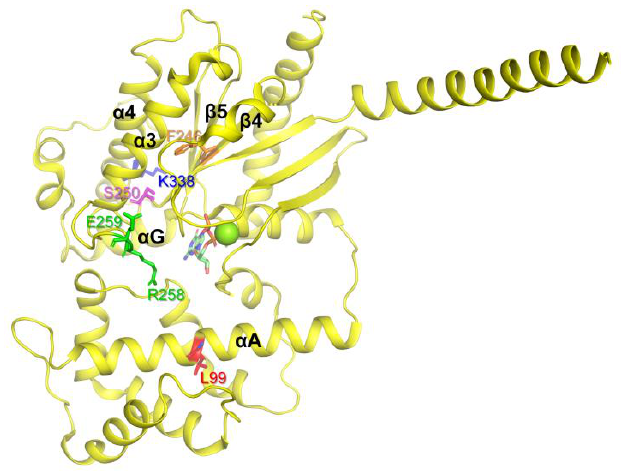
Figure 2. Gαs natural variants that underwent aggregation in the E. coli expression system. The G α s natural variants that underwent aggregation are shown as sticks on the structure of GDP-bound G α s (PDB: 6EG8).